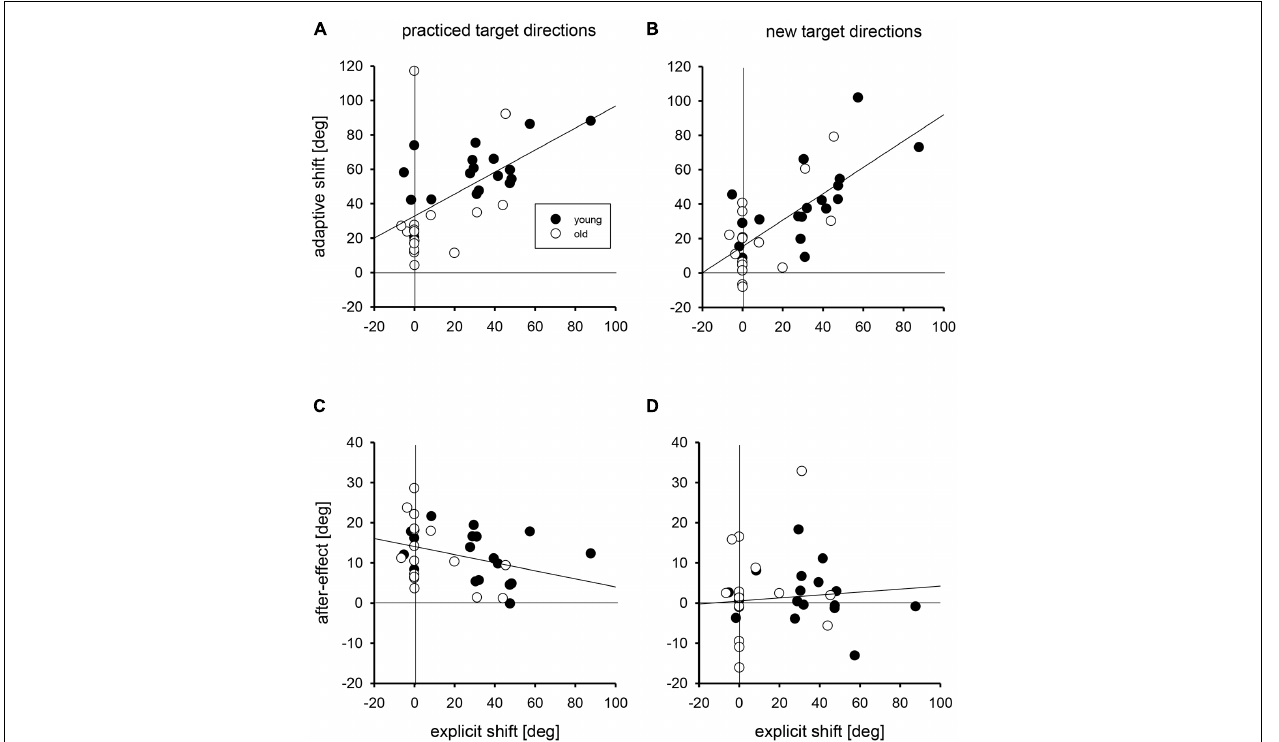
FIGURE 3 |The regressions of individual adaptive shifts for practiced (A) and new target directions (B) and of individual after-effects for practiced (C) and new target directions (D) on individual explicit shifts. Filled circles